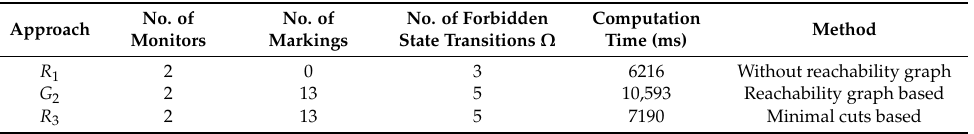
Table 14. Comparison results of case study